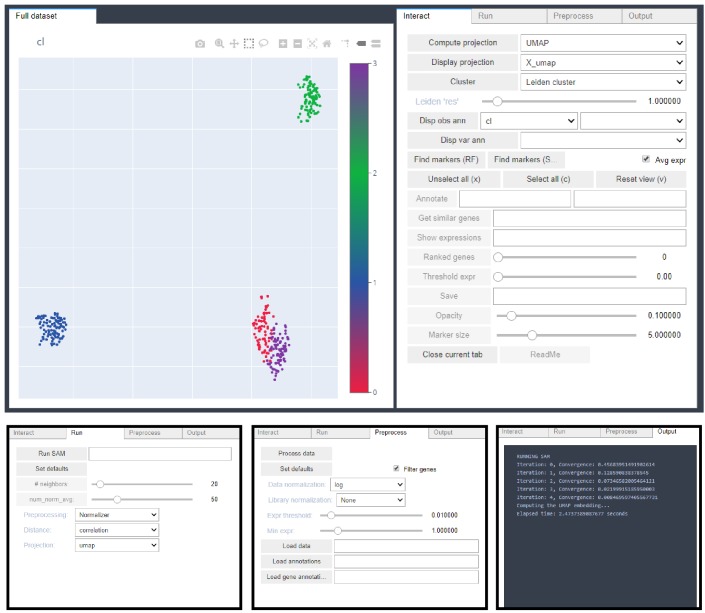
A user interface for interactively exploring single-cell data using SAM.An interactive Jupyter notebook interface provided by the SAM package facilitates convenient visualization of single cell data (upper left) and changing of SAM parameters using various control panels (upper right, and bottom). This interface allows clustering, subclustering, visualizing of gene expression, and many other applications.